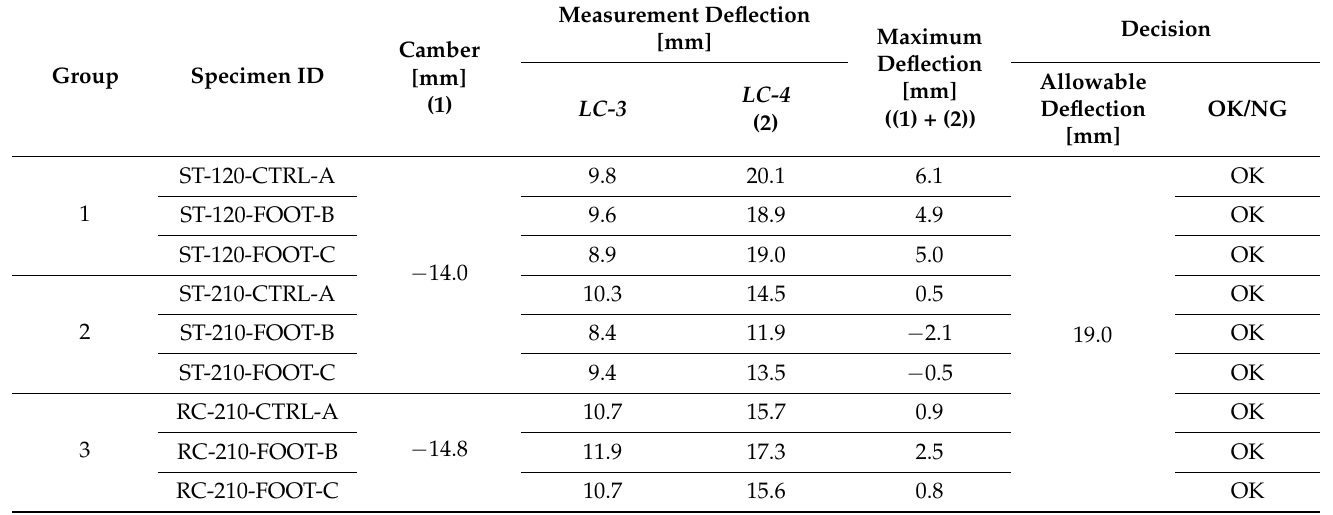
Table 6. Summary of deflection